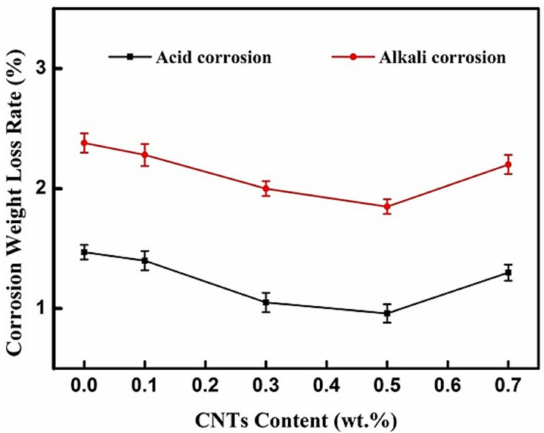
Figure 5. The weight loss rate of the CNT-BF / EP coating in 3 mol / L HCl and 3 mol / L NaOH solutions.